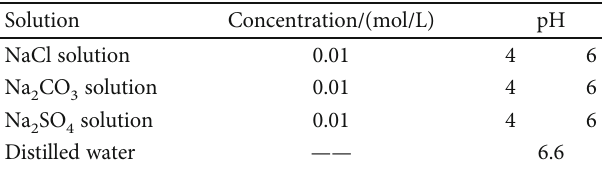
Table 2: Speci fi cs of solutions used in this study.